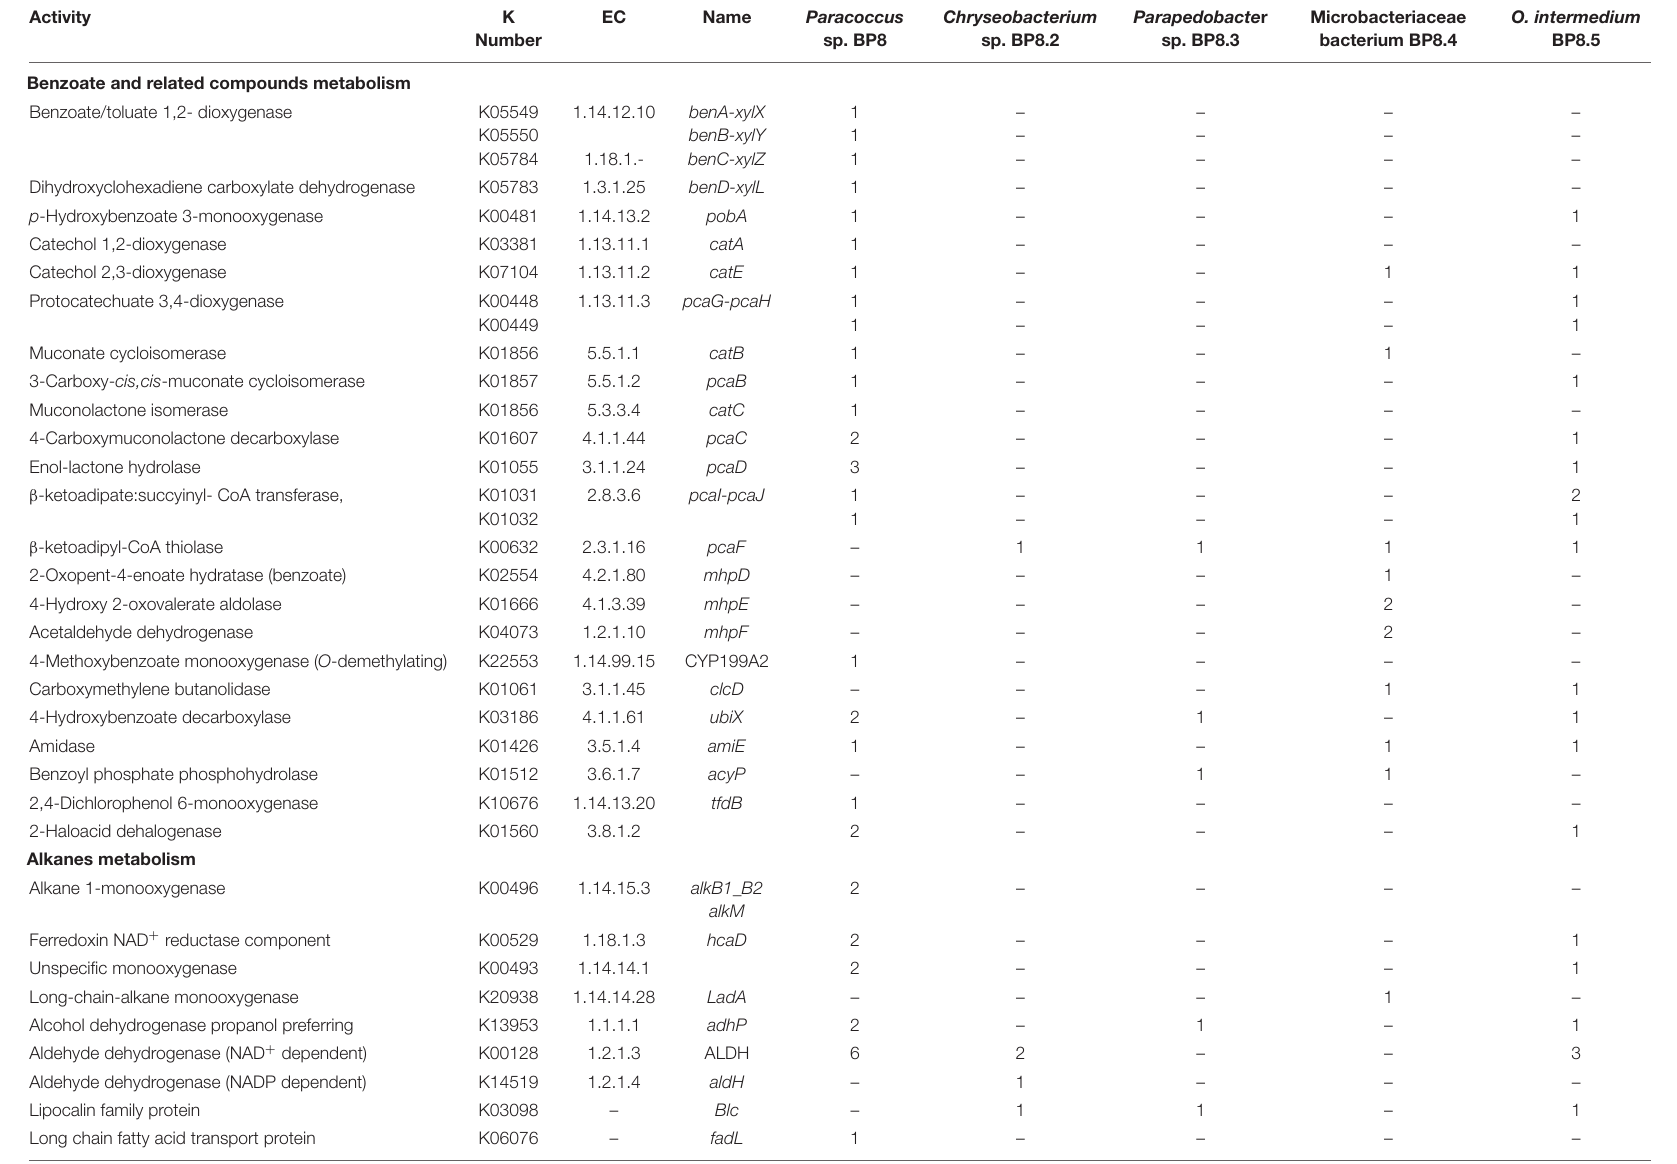
TABLE 3 | Distribution of genes encoding relevant proteins involved in xenobiotics degradation in the BP8 metagenome.